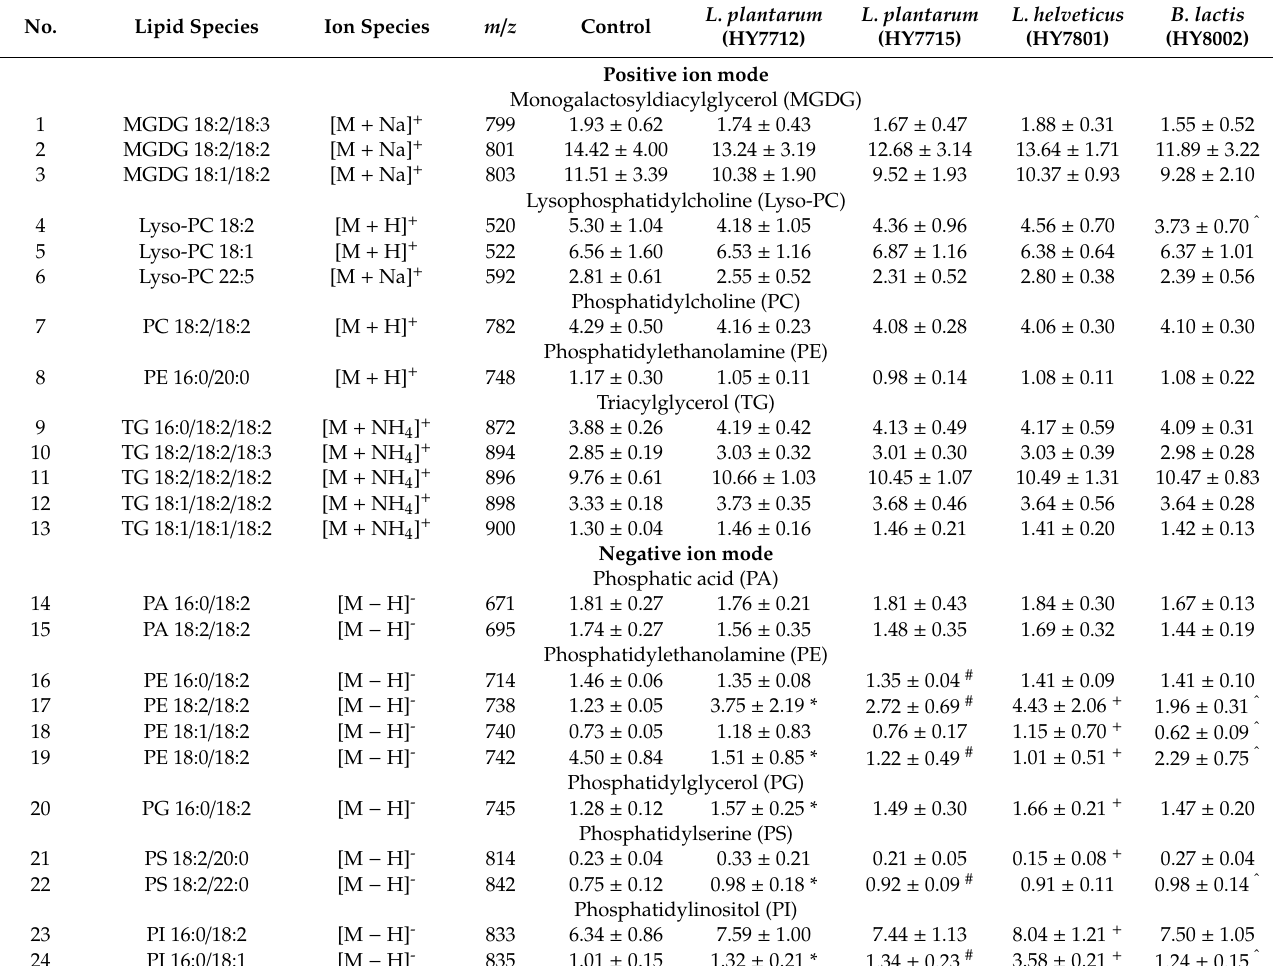
Table 2. Relative levels of lipids in the fermented and non-fermented VJs, as detected by